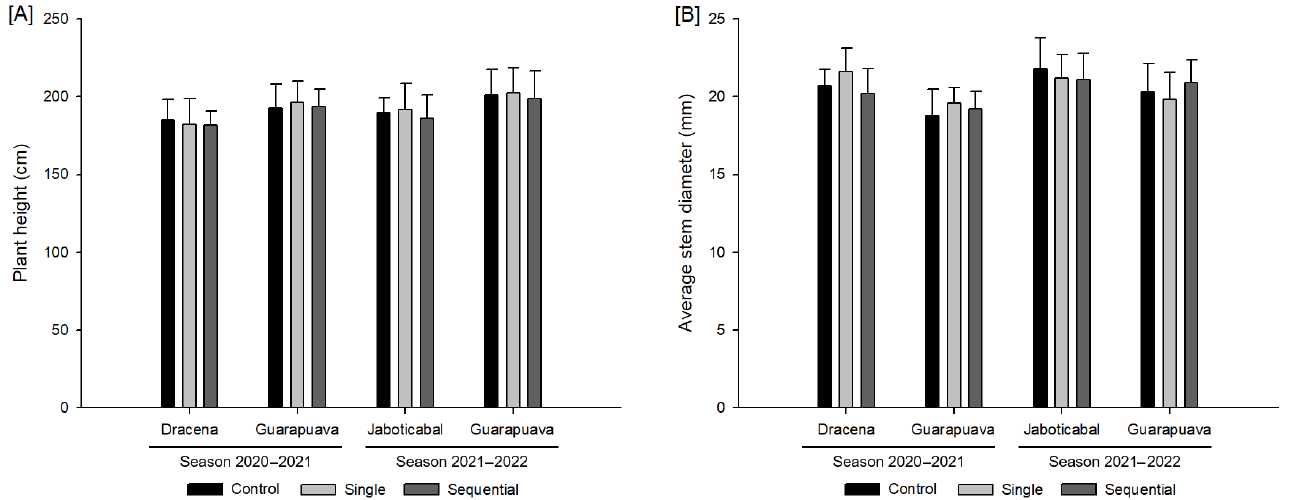
Figure 1. Plant height ( A ) and average stem diameter ( B ) at the pre-flowering time of GR maize grown with no glyphosate application (control), with a single application (980 g a.e ha −1 ) at stage V5 or a sequential application of glyphosate at the V3 (520 g a.e ha − 1 and V7 (980 g a.e. h − 1 ) growth stages in three locations and two seasons. Error bars are one SE of the mean from ten